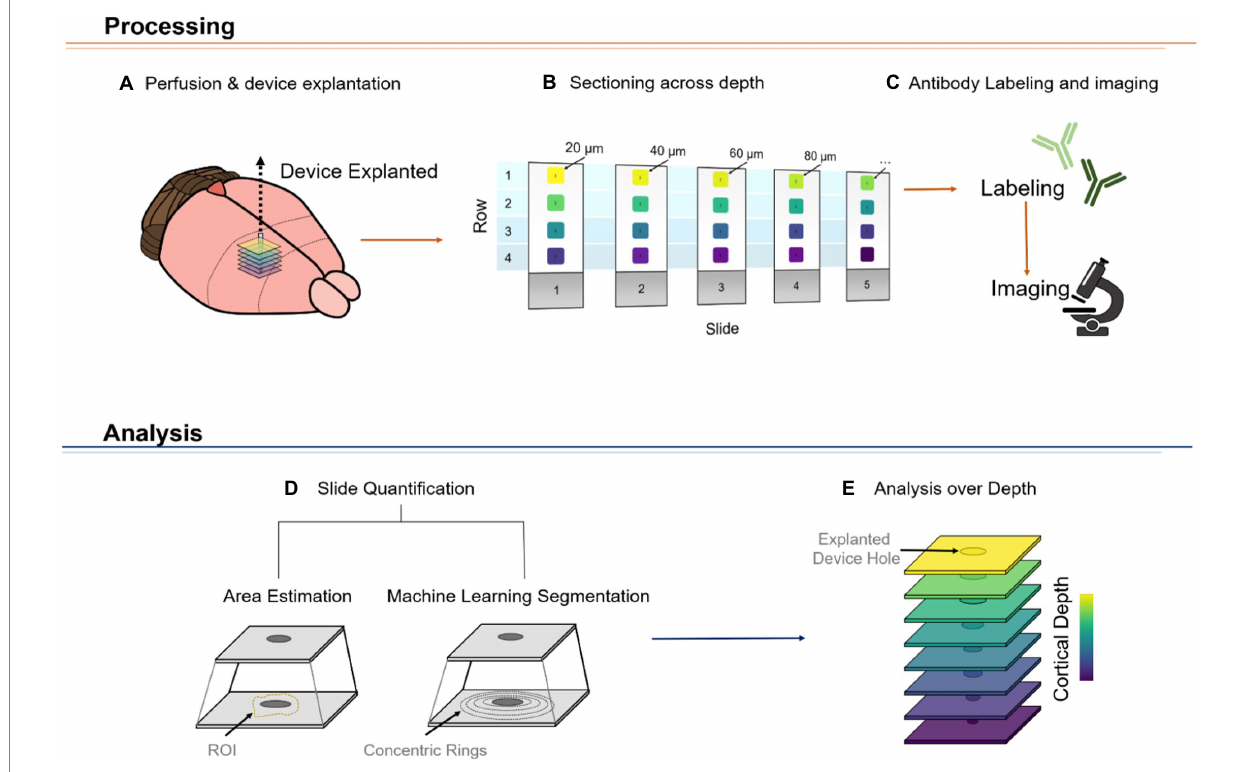
FIGURE 6 Representative diagram of DeepHisto pipeline. The tissue processing phase consists of carefully removing the silicon microelectrode after perfusion and fixation of the brain with paraformaldehyde (A) . The area around the explanted device is isolated and systematically cryosectioned to keep track of the relative depth of each cut (B) . The slides are then labeled with antibodies and imaged (C) . Subsequently, the tissue response of each imaged slide is quantified (D) . This quantification process could be achieved by either estimating the region of interest (ROI) of a specific marker (i.e., delineating the area neuronal cell loss around the electrode) or by obtaining fluorescence intensity levels of concentric rings around the device hole. Lastly, by plotting these values over depth, a depth-specific profile of the tissue response can be obtained (E)